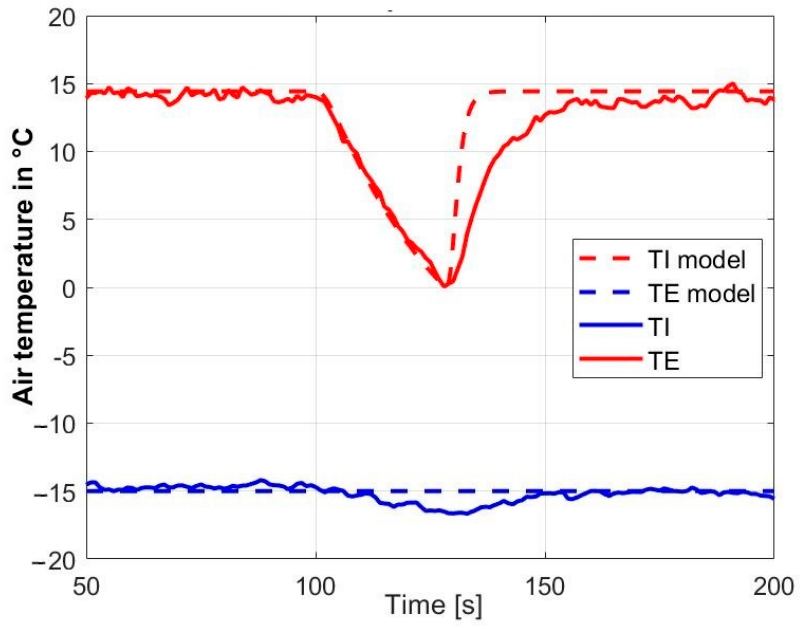
Figure 11. Diagram of comparison between model and experimental data for a number of sections n = 10 for air temperatures.